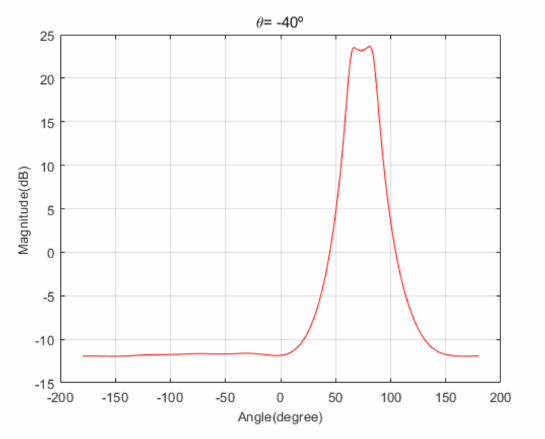
Figure 11. Spatial spectrum of CAPON for the third scenario (elevation angle = − 40 ◦ ).